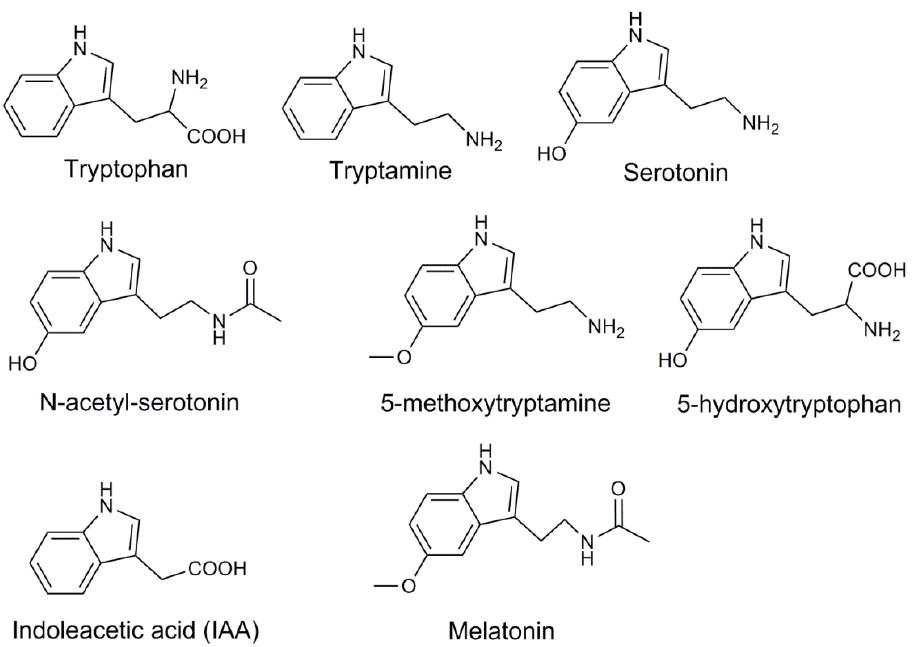
Figure 2. Chemical structures of all the compounds in melatonin biosynthesis pathway.